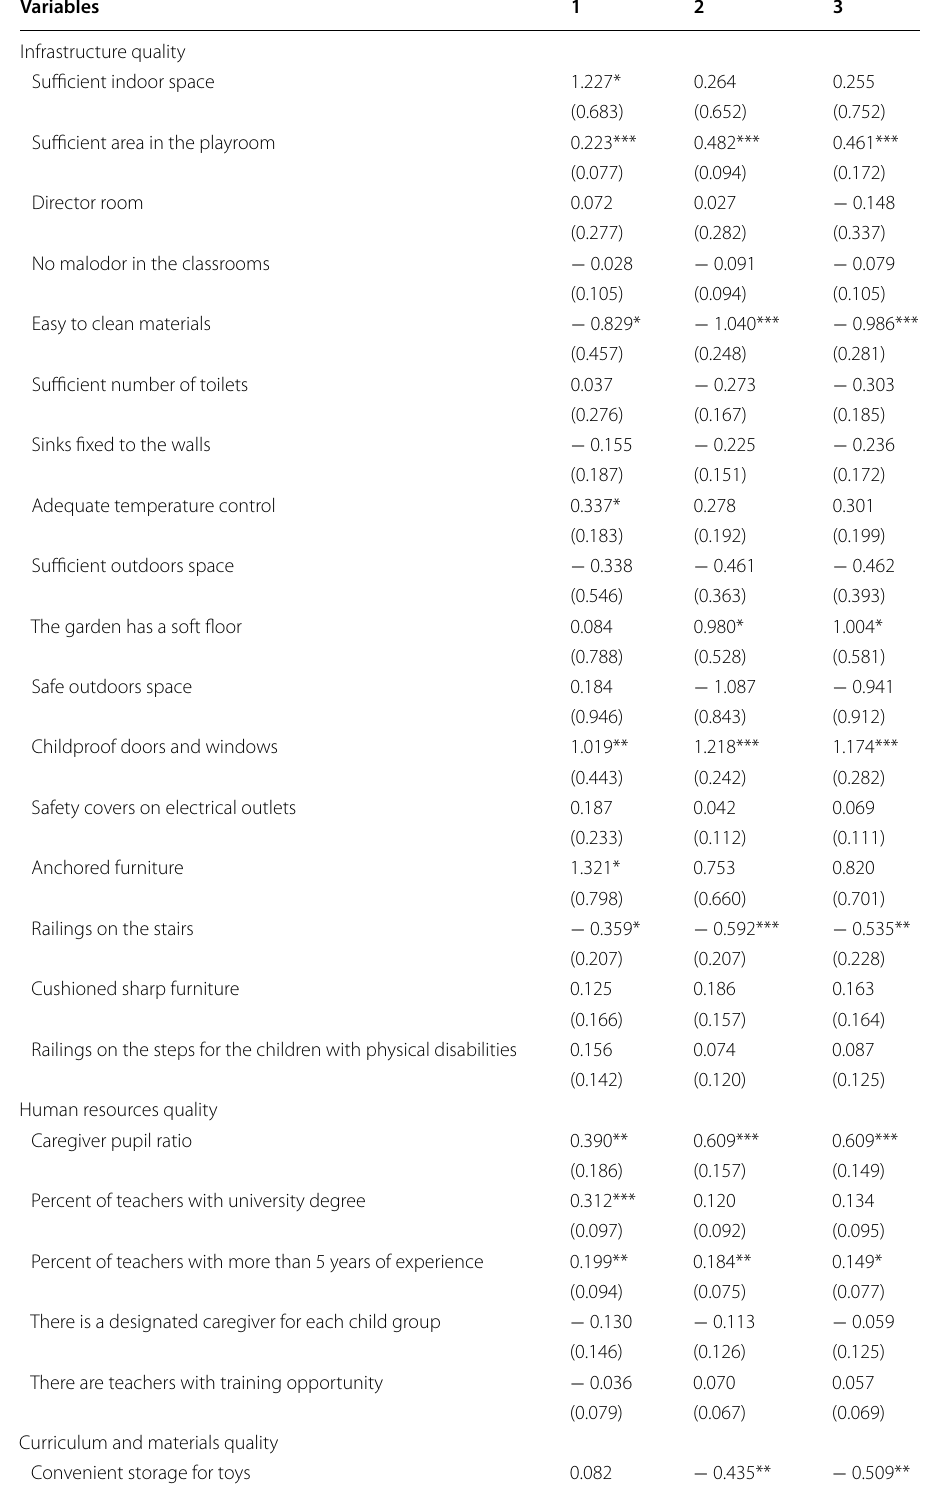
Table 3 OLS results for the price equation (individual quality variables) Variables 1 2